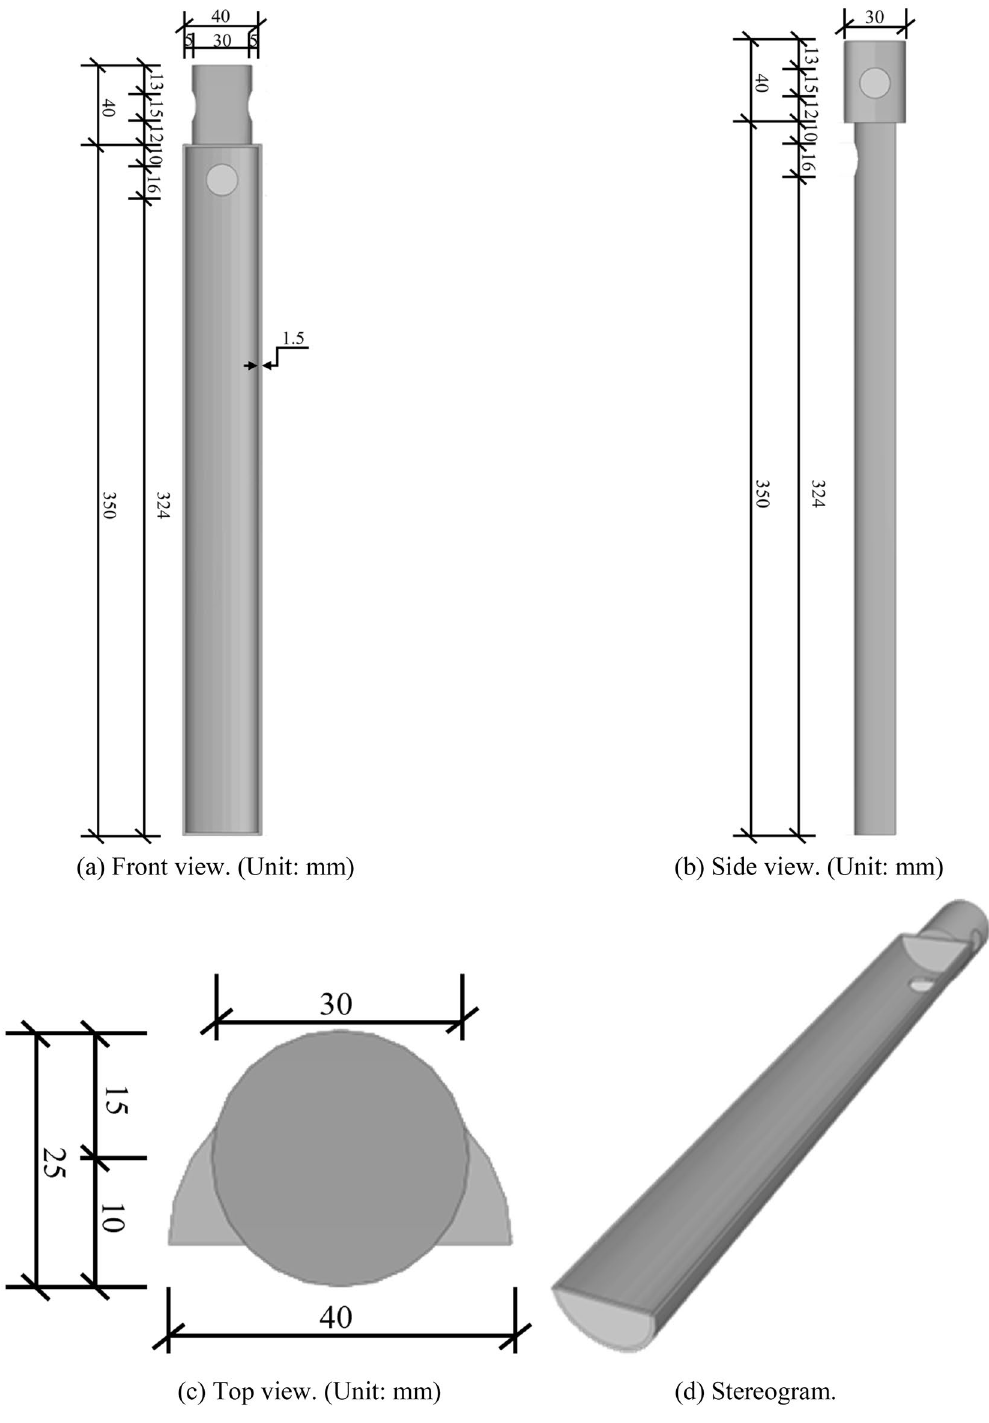
Figure 3. Schematics of the model